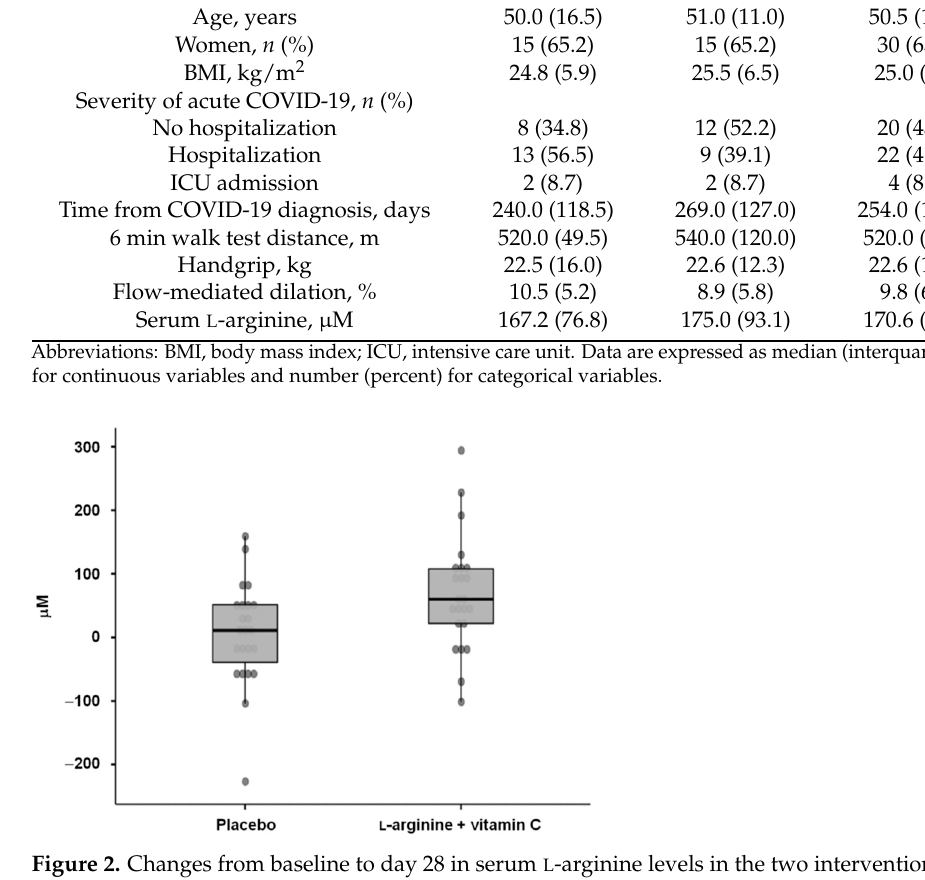
Figure 3. Changes from baseline to day 28 in the 6 min walk test distance in the two intervention groups. At 28 days, L -arginine plus vitamin C supplementation induced greater improve- ments in handgrip strength (+3.4 (7.5) kg) compared with the placebo (+1.0 (6.6) kg, p = 0.03; mean difference = 3.4 kg, 95% CI: 0.5 − 9.4 kg; effect size = 0.37) (Figure 4A). At base- line, around 60% of the study participants had a handgrip strength below the 25th per- centile of age- and sex-specific reference values [37]. After 28 days of intervention, more participants who received L -arginine plus vitamin C than those in the placebo group (57%